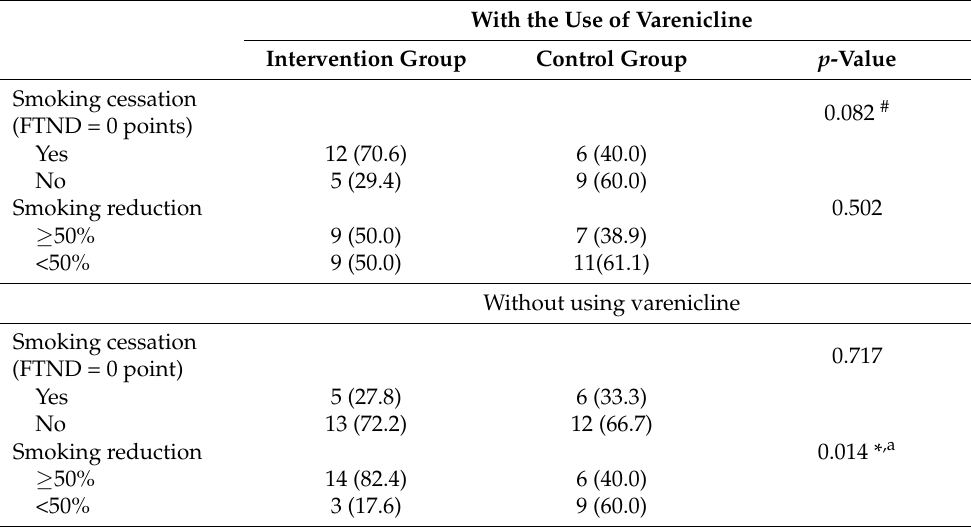
Table 3. Result of smoking cessation and smoking reduction of the